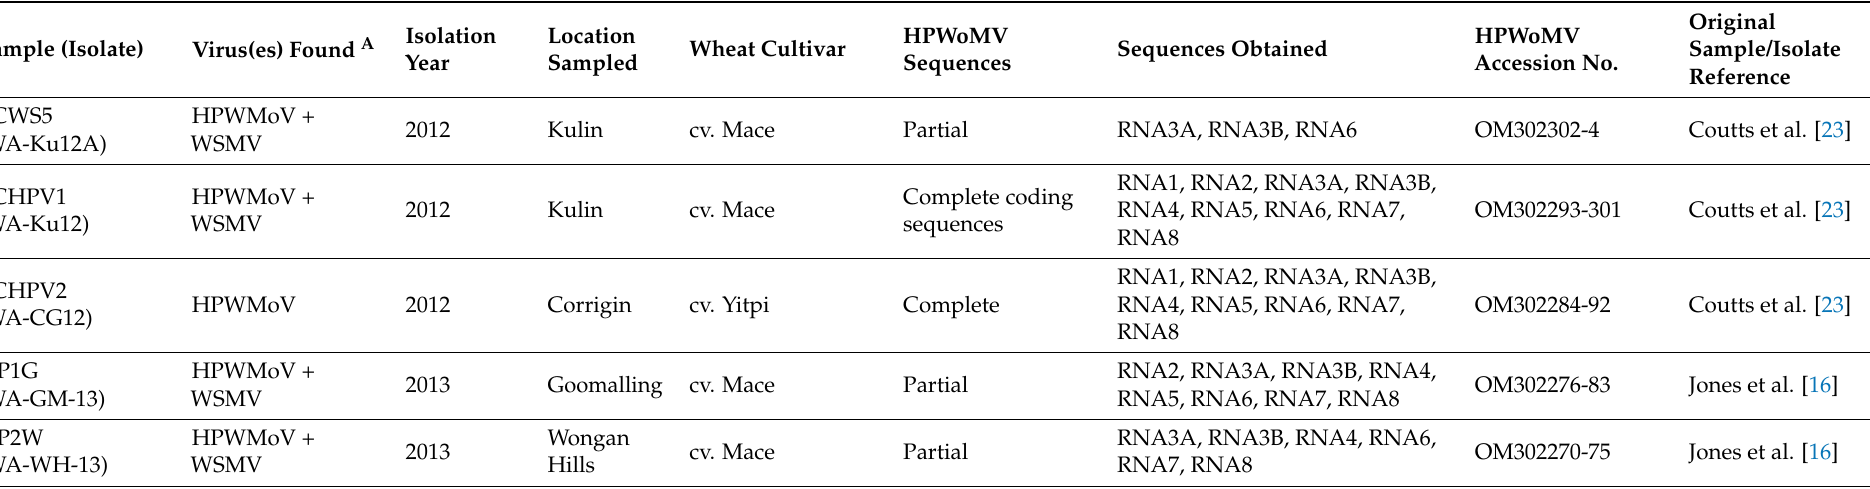
Table 1. Virus-infected samples of wheat from south-west Australia that contained High Plains wheat mosaic virus: sample names, virus(es) present, origins, and sequence accession